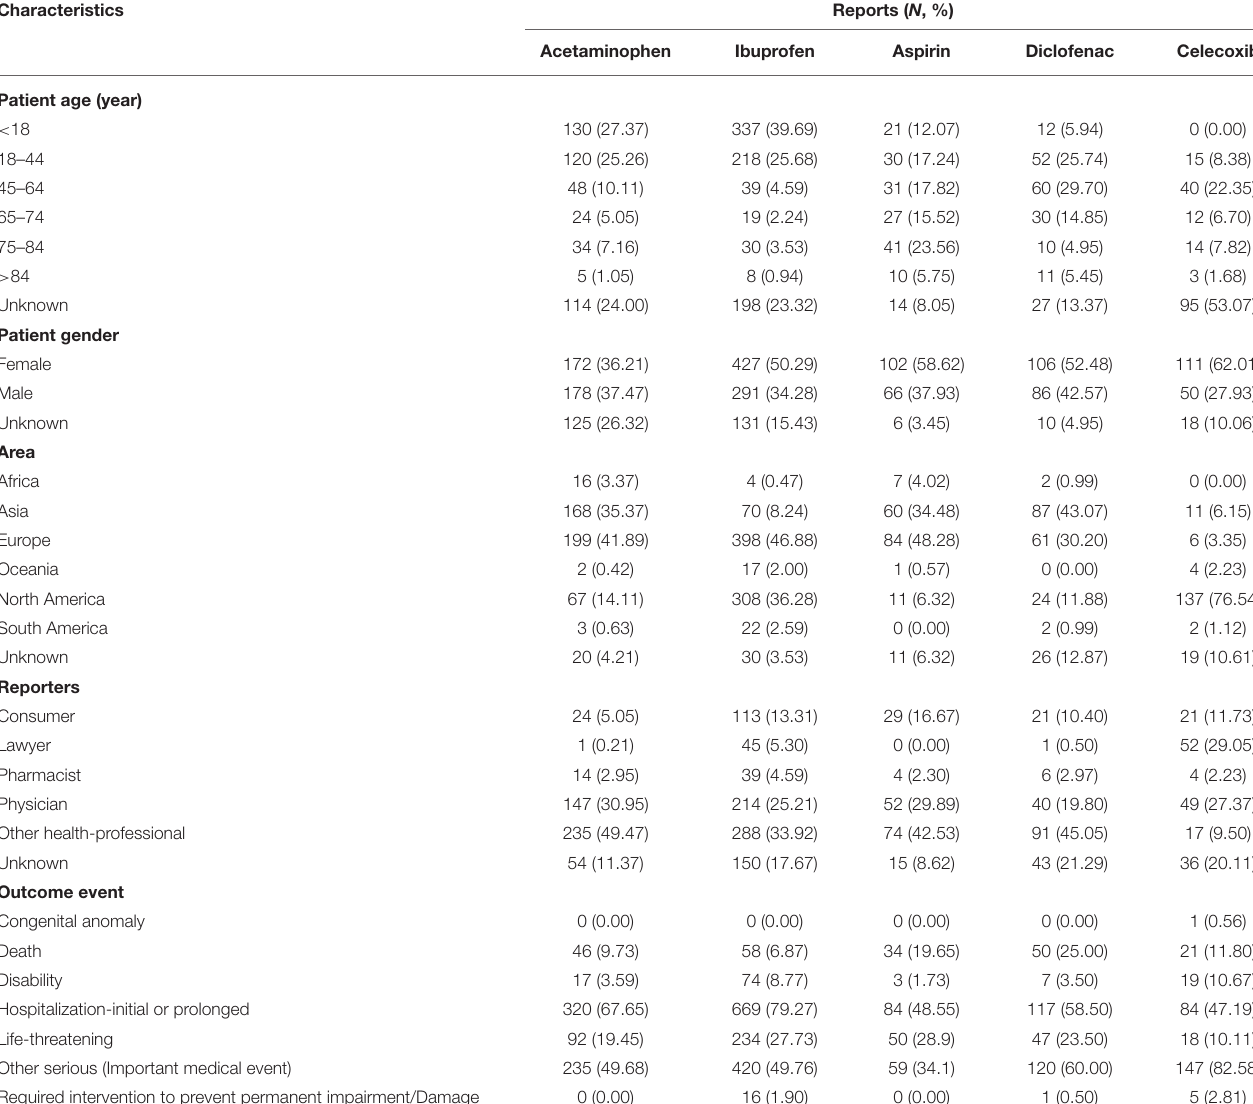
TABLE 3 | Clinical characteristics of patients with NSAIDs-associated Stevens-Johnson syndrome collected from the FAERS database (January 2004 to March 2021).